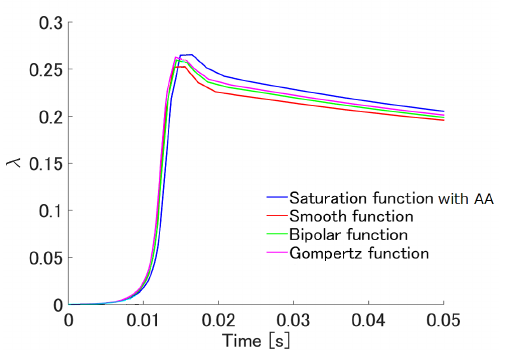
Figure 12. Enlarged view of time response of driving torque on dry asphalt (( 0 < t < 0 : 05 )